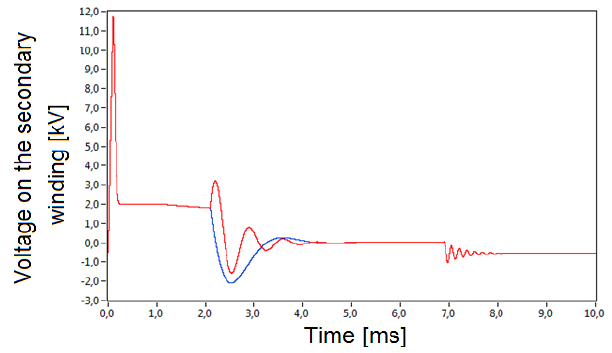
Fig. 6. Changes in the ignition voltage course on the secondary side in the case of shorting of the winding in the ignition coil or piercing of the capacitor